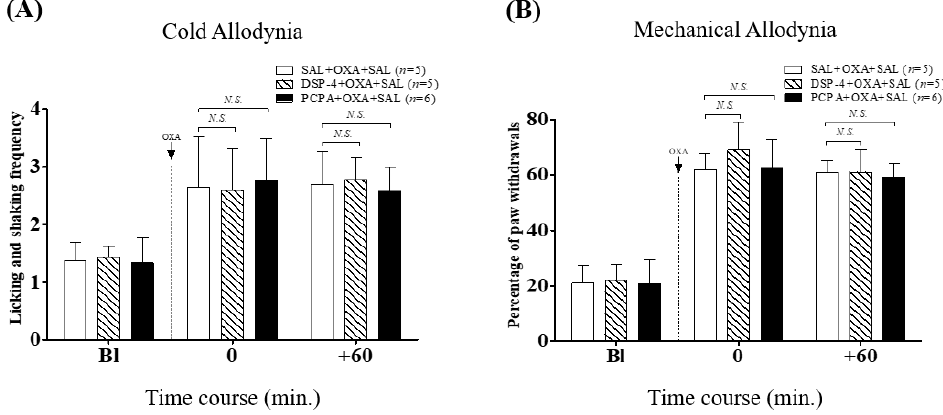
Figure 2. Effects of noradrenaline or serotonin depletion on cold ( A ) and mechanical ( B ) allodynia induced by oxaliplatin administration. Before oxaliplatin (OXA, 6 mg/kg, i.p., dotted line) administration, mice were treated with single DSP-4 (50 mg/kg, i.p.) or three consecutive para-chlorophenylalanine (PCPA) injections (150 mg/kg/day, i.p.). On day four, the measurements were performed before the injection of saline (SAL) and 60 min after. “Bl”, baseline; N.S. , no significance ( p > 0.05), vs. SAL + OXA + SAL. Data was expressed as mean ± S.D. and analyzed with two-way ANOVA followed by Bonferroni’s post-test.